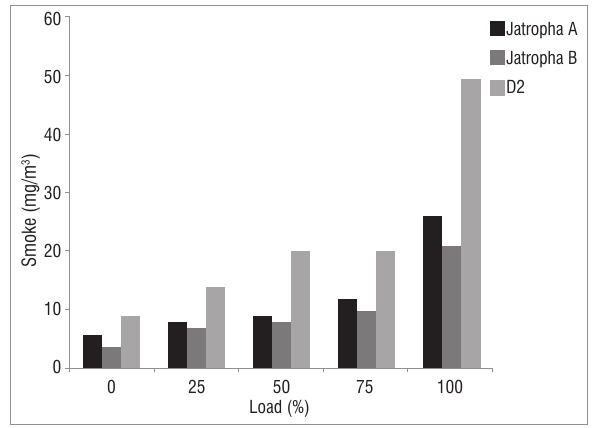
Figure 6: Smoke emissions for the different fuel samples at different loads. Combustion analysis Variation in injection timing exerts a major influence on engine performance and exhaust emissions. To understand and optimise the combustion process, a careful analysis of cylinder pressure and heat release was performed, which furnished precise information about the combustion of biodiesel. A TDI compression ignition engine was used to undertake an analysis of the combustion characteristics of the fuel samples tested.